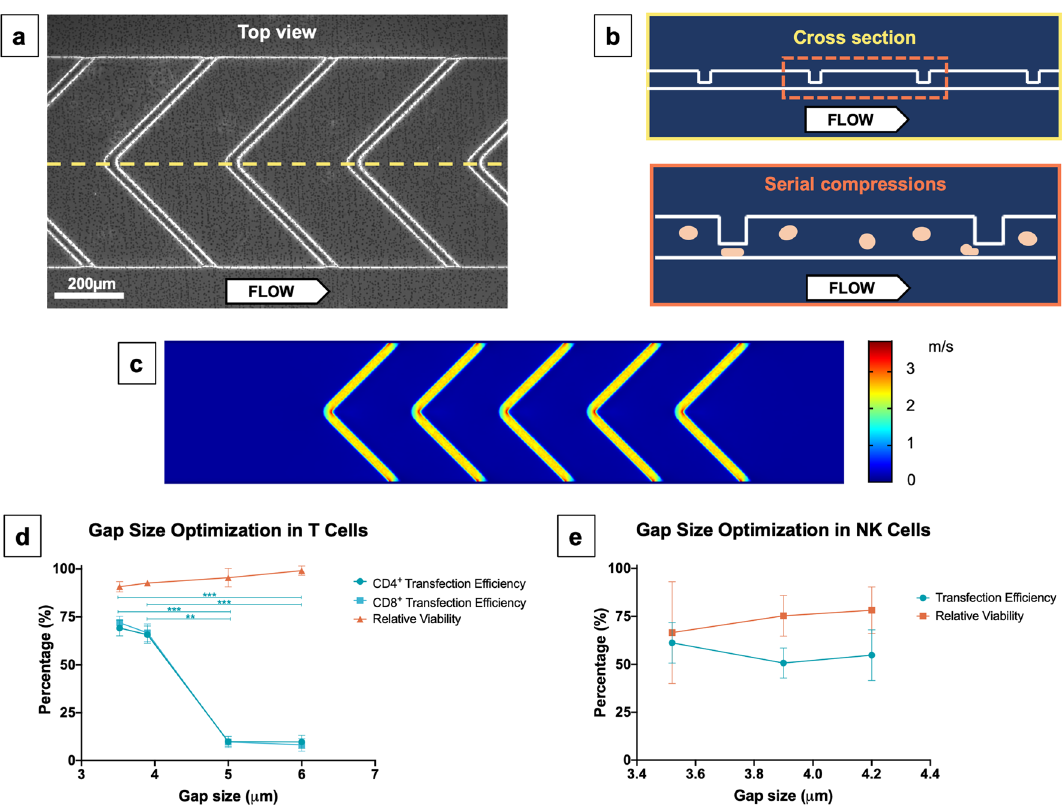
Figure 1. Optimization of a microfluidic device for volume exchange for convective transfection (VECT) in human primary cells. ( a ) Top-view microscopic image of the device, showing the shape of the ridge elements across the channel. ( b ) Top, representation of the cross section highlighted in yellow in ( a ), depicting how the ridges are distributed along the channel. Bottom, representation of the mechanical processing experienced by the cells. ( c ) Fluidic simulation of the velocity of the liquid being run in a working device. ( d ) Gap size optimization for the transfection of GFP-encoding mRNA in T cells performed with devices ranging from 3.5